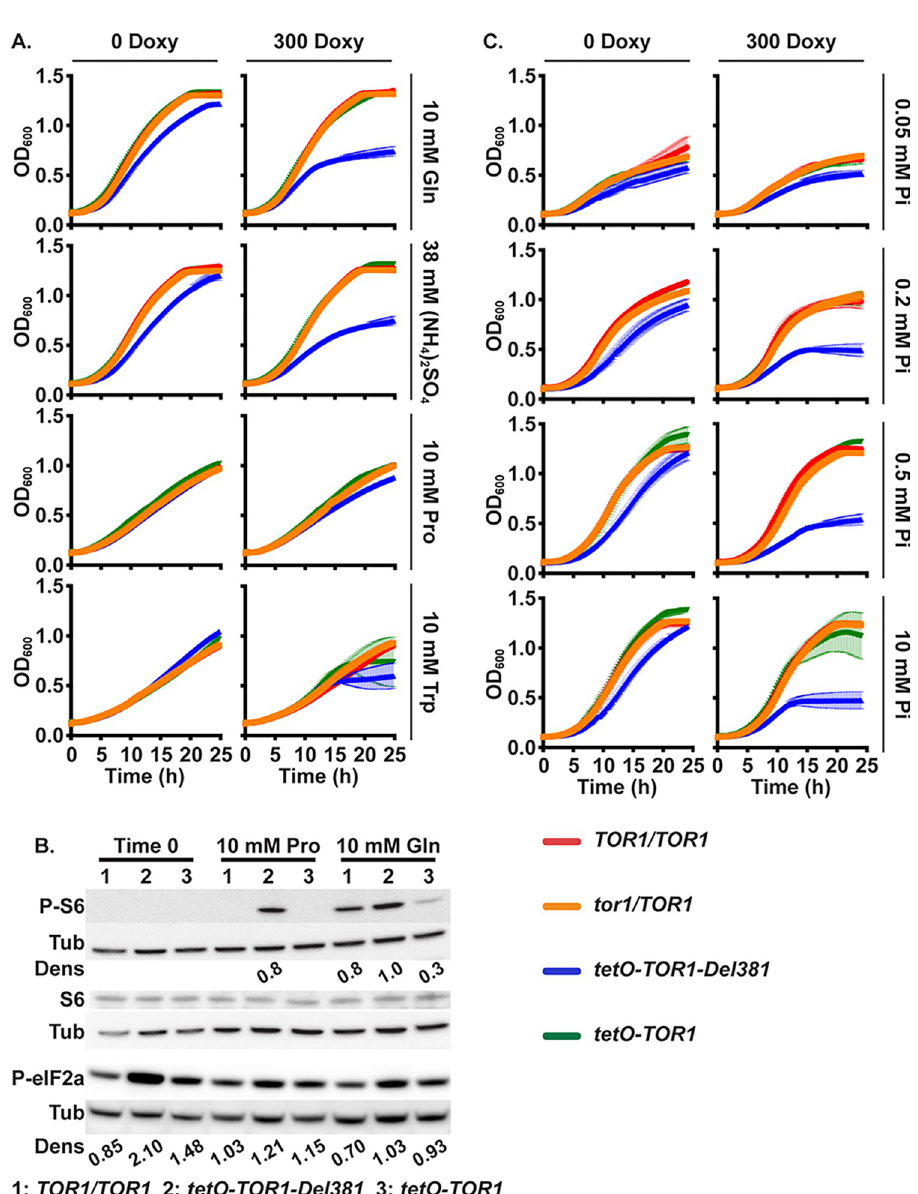
Fig 2. Tor1 N-terminal HEAT repeats were required to accelerate growth and activate TORC1 in response to preferred nitrogen sources and to phosphate. A. Cells of indicated genotypes were grown in YNB without ammonium sulfate ((NH 4 ) 2 SO 4 ) supplemented with 10 mM Glutamine (Gln), 38 mM (NH 4 ) 2 SO 4 , 10 mM Proline (Pro) or 10 mM Tryptophan (Trp) as sole nitrogen source, without or with 300 ng/ml doxycycline (300 Doxy). ( TOR1/ TOR1 , JKC1713; tor1/TOR1 , JKC1347; tetO-TOR1-Del381 , JKC1441; tetO-TOR1 , JKC1549) B. Western blot of cells pre-grown in YPD medium with 2 μ g/ml doxycycline for 4 h (Time 0), then incubated in YNB without doxycycline, without (NH 4 ) 2 SO 4 , with 10 mM Proline (Pro) or Glutamine (Gln) as sole nitrogen source for 45 min; protein extracts probed with antibody to phosphorylated Rps6 (P-S6), total Rps6 (S6) or phosphorylated eukaryotic translation initiation factor 2A (P-eIF2a), and tubulin (Tub) as loading control. Dens: signal intensity ratio of P-S6 or P-eIF2a to Tub. Strains as in panel B and TOR1/TOR1 , JKC1361. Same samples were run on separate gels to detect either P-S6 or P-eIF2a. C. Cells pre-grown as in A were inoculated into YNB without phosphate supplemented with varying concentration of KH 2 PO 4 (Pi), without or with 300 ng/ml doxycycline (300 Doxy). Error bars show SD of 3 technical replicates. Strains as in panel A and tor1/TOR1 , JKC1347.